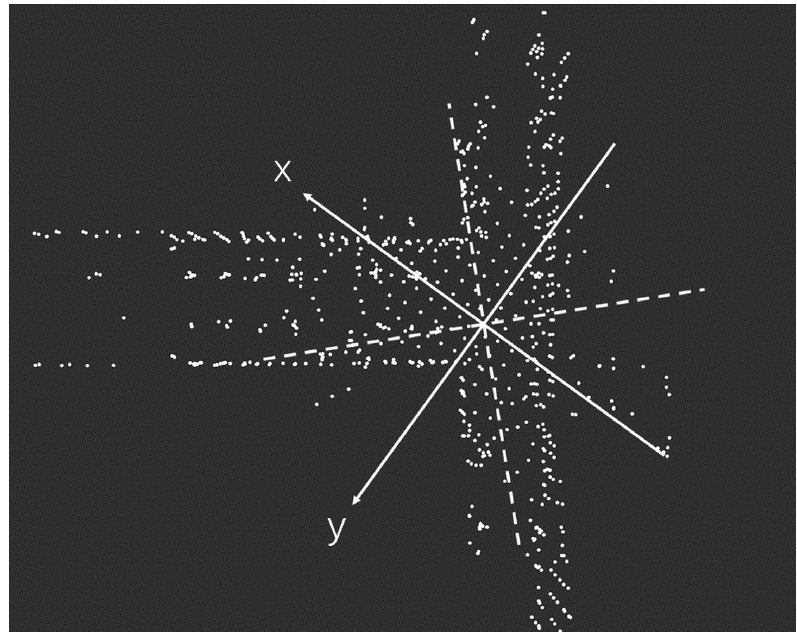
Figure 12. NDT valid matching points on